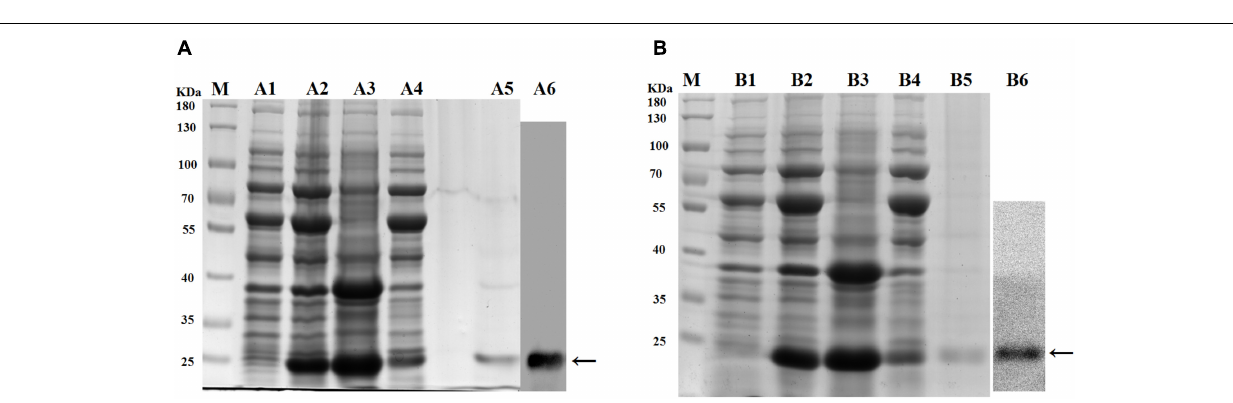
FIGURE 5 | SDS–PAGE of recombinant proteins and western blotting. (A) : rApPGRP-1, (B) : rApPGRP-2. lane M, molecular mass standards; lane A1, B1, total cellular extracts from Escherichia. coli Chaperone Competent Cells pG-KJE8/BL21 with pCold II before induction; lanes A2, B2, total cellular extracts from IPTG induced E. coli cells (containing expression vector); lanes A3, B3, pellet of total cellular extracts from IPTG induced E. coli (containing expression vector); lanes A4, B4, supernatant of total cellular extracts from IPTG induced E. coli (containing expression vector); lanes A5, B5, purified rApPGRP-1 and rApPGRP-2; lanes A6, B6, western blot. The bands of target protein are labled by ← .